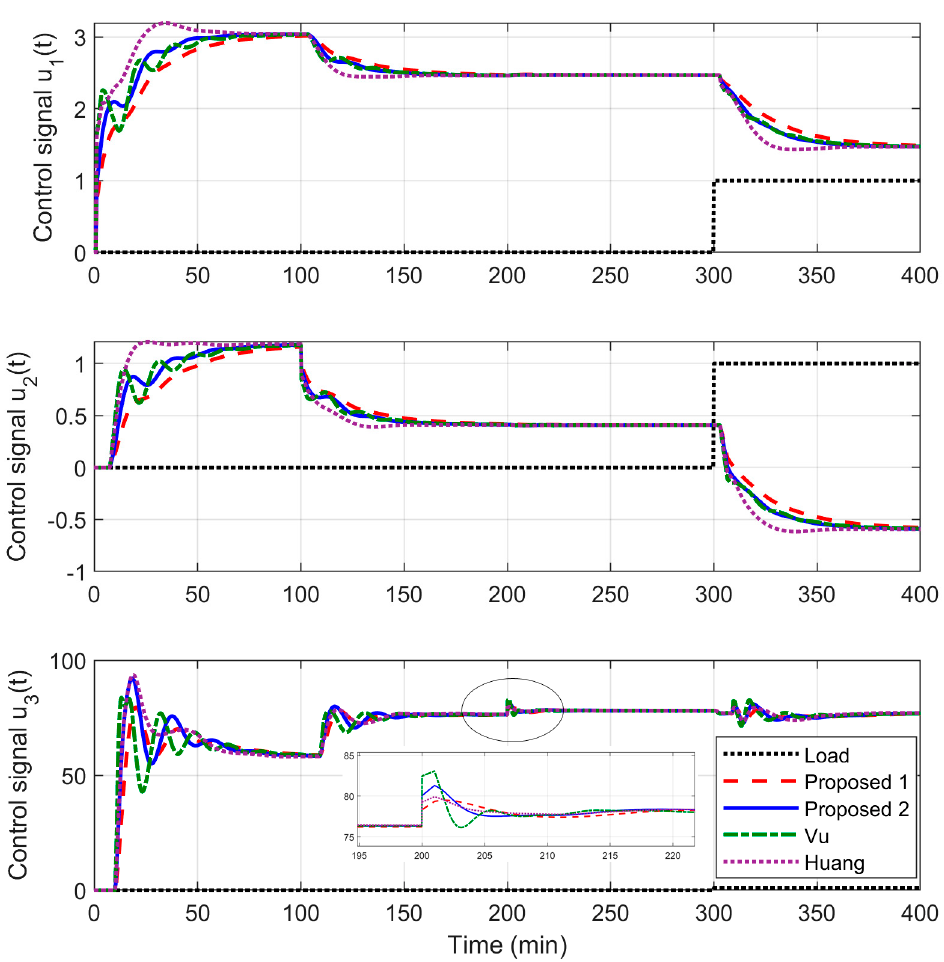
Figure 15. Closed loop system responses of control signals in example 2.